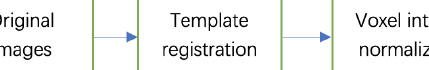
Figure 1. The flowchart of image preprocessing.